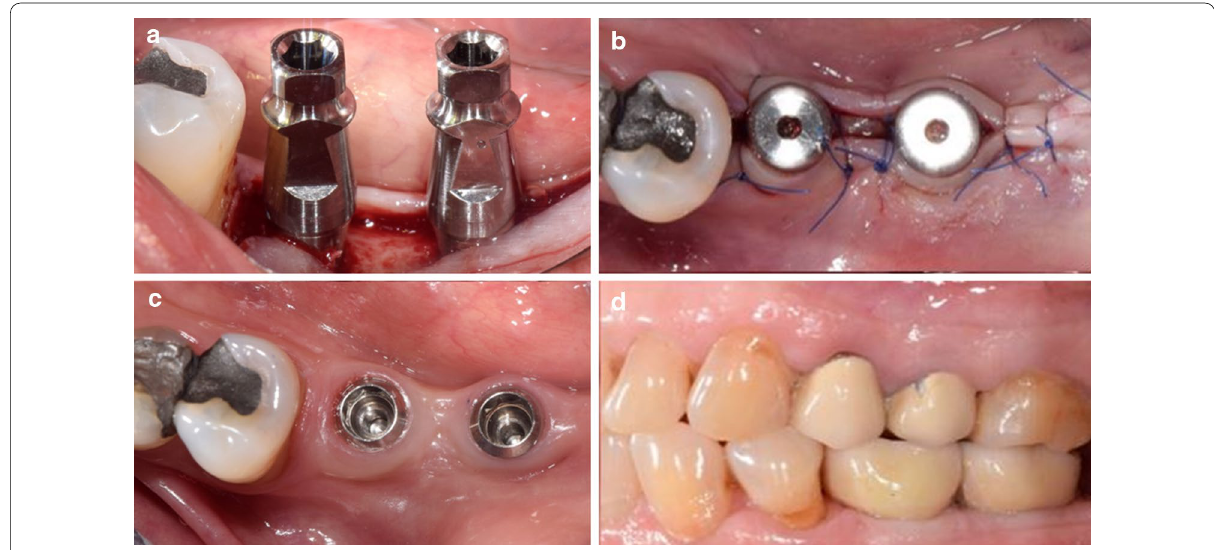
Fig. 1 Tissue level implants. a Insertion the with polished rough surface at the level of the bone crest, b healing abutments placed at tissue level, c and d healing and final